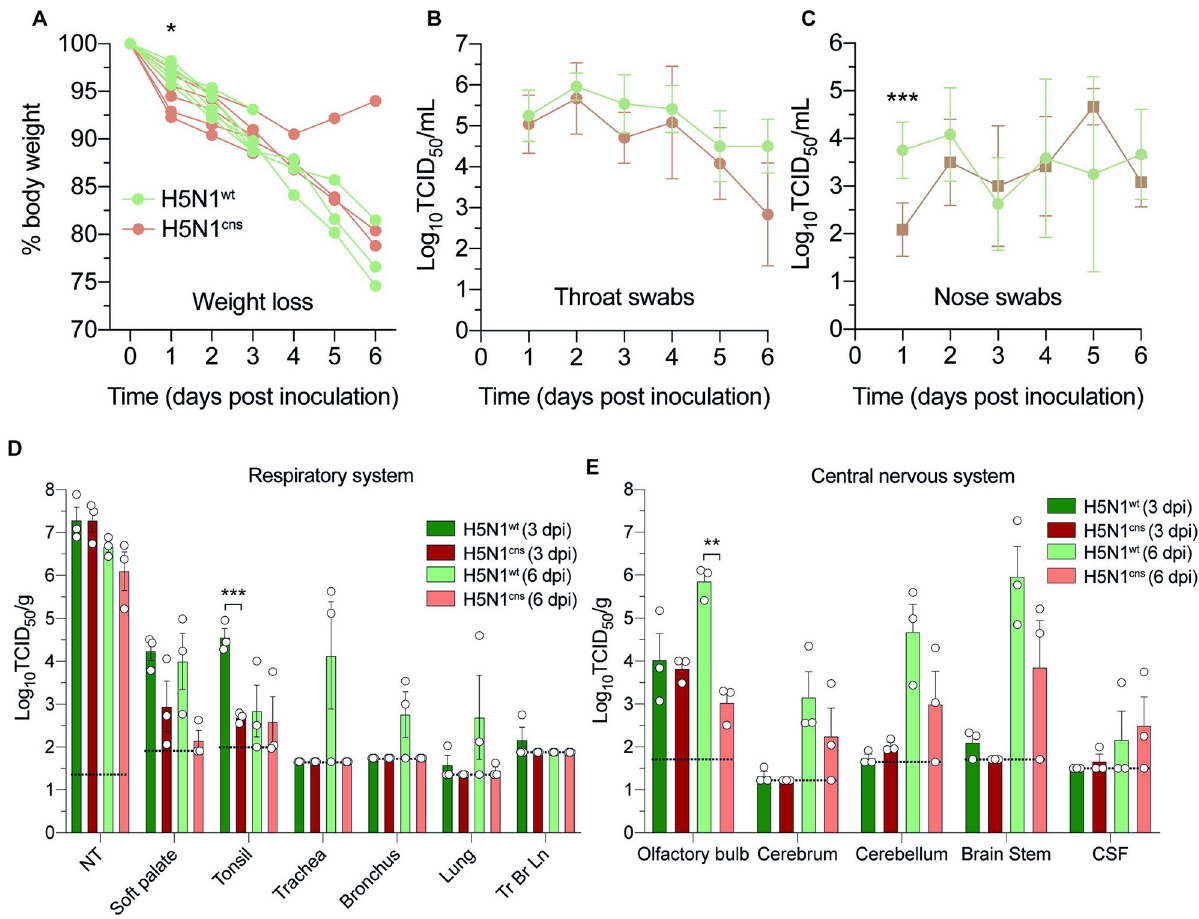
Fig 3. In vivo experimental infection of ferrets with of H5N1-CNS or WT-virus. A, weight loss (% of starting body weight) of ferrets inoculated with H5N1-WT or H5N1-CNS virus. Virus titers in throat (B) and nose (C) swabs. D, virus detection in respiratory tract tissues. NT; nasal turbinates, Tr Br Ln; tracheobronchial lymph node. E, virus detection in different regions of the central nervous system. CSF; cerebrospinal fluid. Data are presented as means ± SDs. Statistical analysis was performed using multiple independent unpaired t-tests. TCID; tissue culture infectious dose, � ,p � 0.05; �� , P � 0.01; ��� , p � 0.001. Dotted lines represent the limit of